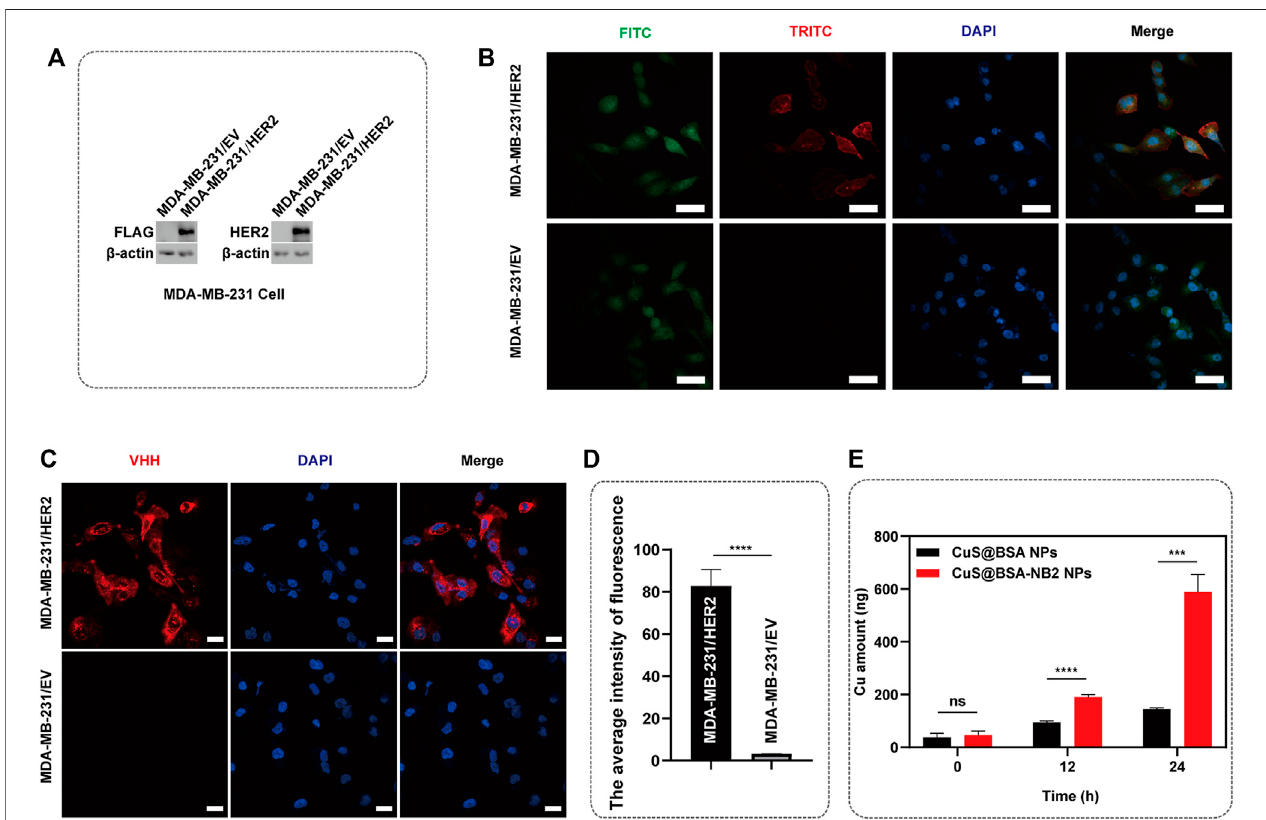
FIGURE 5 | Speci fi city of CuS@BSA-NB2 NPs to HER2. (A) The western blot of the stable cell strains were constructed into MDA-MB-231 cells. (B) Immuno fl uorescence images of MDA-MB-231/HER2 cells and its control group. The scale bar was 50 μ m. (C) Immuno fl uorescence images of MDA-MB-231/HER2 cells and its control group treated with CuS@BSA-NB2 NPs. The scale bar was 20 μ m. (D) The average intensity of VHH fl uorescence ( n (cid:1) 6, **** p < 0.001). (E) The cellularuptakeCuamountofMDA-MB-231/HER2cellstreatedby50 μ g/mlCuS@BSANPsandCuS@BSA-NB2NPsrespectivelyfor0,12and24 h( n (cid:1) 3,**** p < 0.0001, *** p <